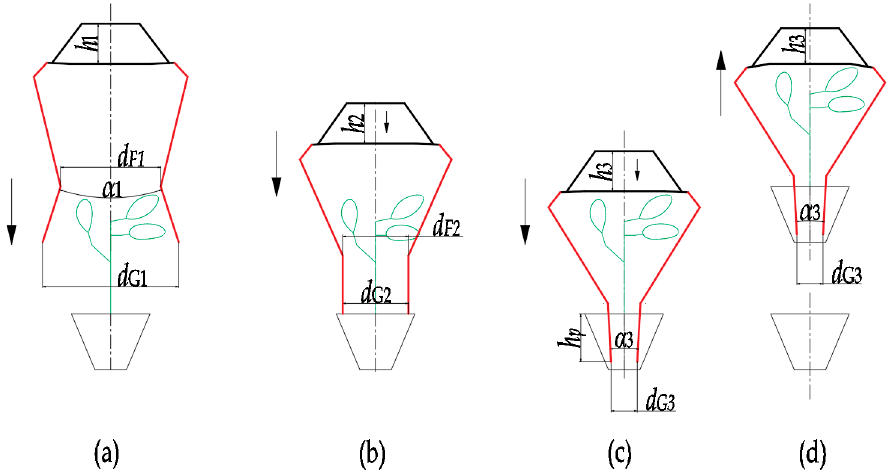
Figure 7. Operation of picking up seedlings. ( a ) The manipulator keeps open until starts to work. ( b ) The fingers of working manipulator are touching upper surface of the pot. ( c ) The fingers are in the closed state to clamp the pot. ( d ) Fingers keep closed state to pick up seedling.